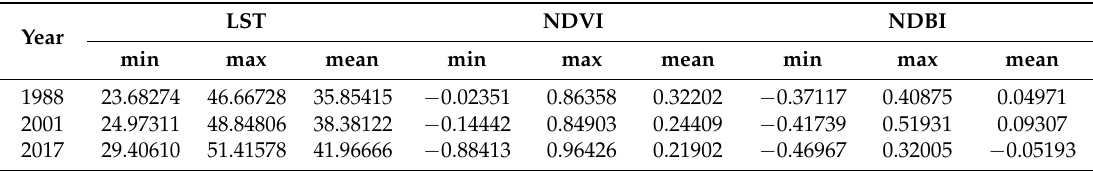
Table 5. Details of the calculation of LST, NDVI and NDBI in 1988, 2001 and